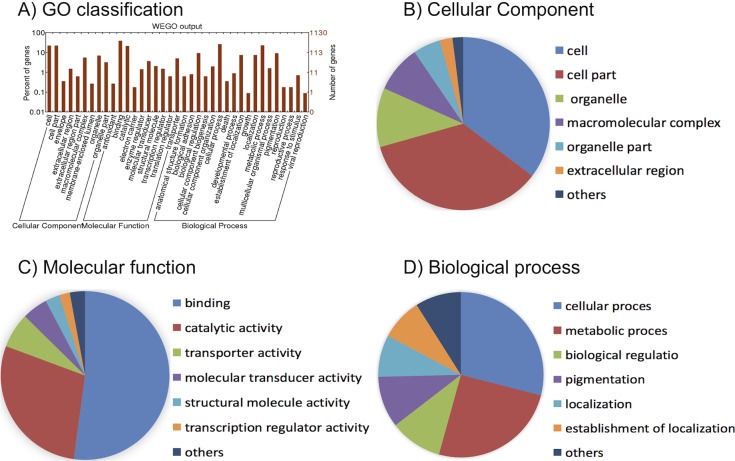
Gene Ontology (GO) analysis of differentially expressed genes (DEGs) of Aedes albopictus transcriptome annotated to UniGene cDNA reference data.Analysis was performed with Blast2GO-PRO. A) Histogram of Ae. albopictus differentially expressed sequences GO classification. Three main ontologies of GO (biological process, cellular component, and molecular function) are shown in the x-axis. The left y-axis indicates the percentage of total genes, and the right y-axis is the number of genes in each category. B) Distribution of transcripts in category of cellular components. C) Distribution of transcripts in category of molecular functions. D) Distribution of transcripts in category of biological processes.